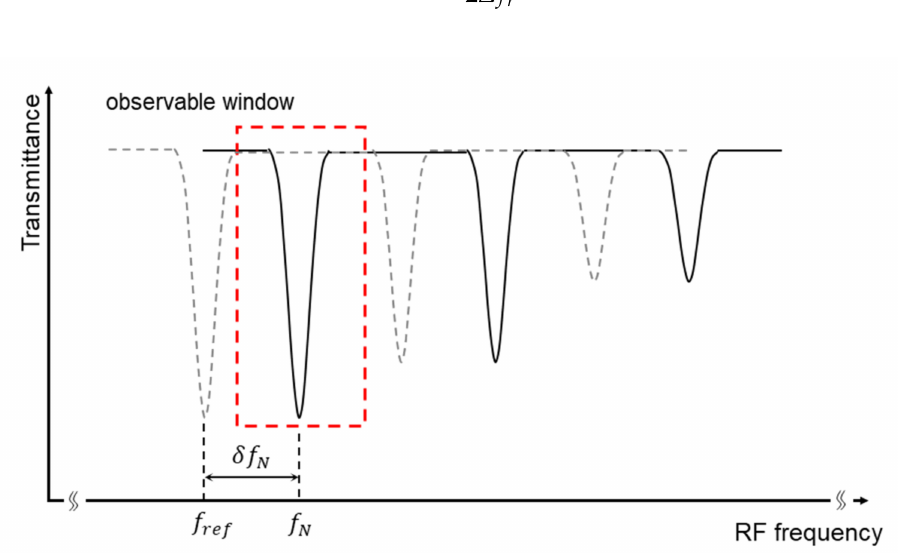
Figure 4. Diagram of center frequency variation extraction method. As center frequency jitter is dominant compared to repetition frequency difference jitter, real-time transmittance spectra can be assumed as high fidelity with merely overall center frequency drift. To estimate center frequency variation δ f N frame by frame, 45 kHz observable window can be isolated around a specific ab- sorption line. After removing the residual baseline, the drift of the center of gravity within each observable window can be recorded as δ f N . In this figure, center frequency variation is exaggerated for illustrative